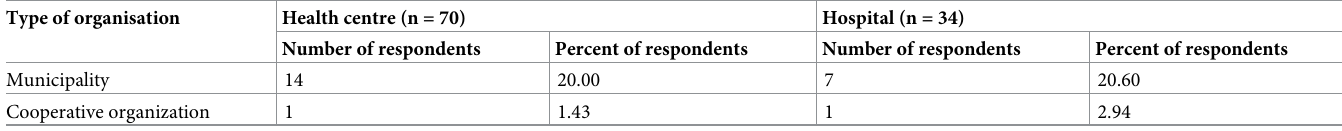
Table 9. Managers response to off-site HCW collectors in the study health facilities, Addis Ababa City Administration, February 2018. Type of organisation